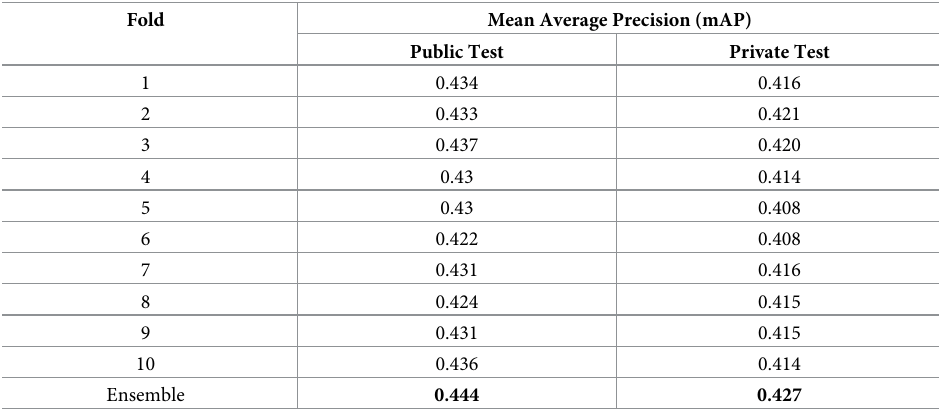
Table 5. Mean average precision. Fold